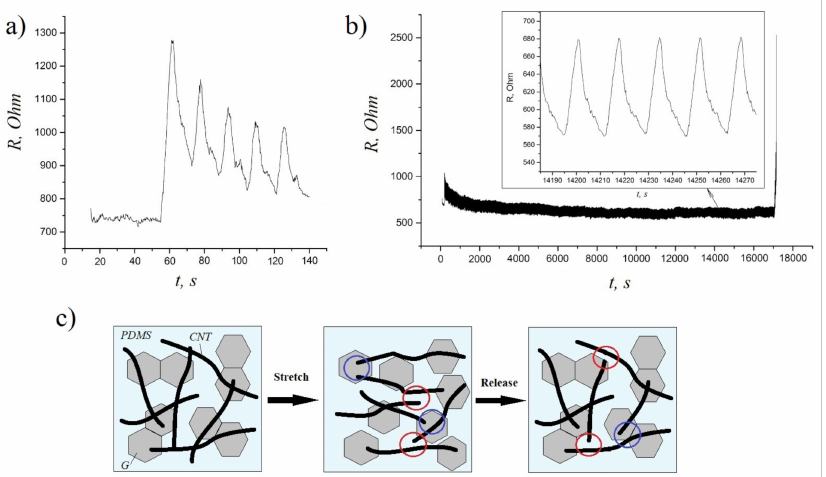
Figure 5. (a ) The resistance response of hybrid composites at the initial cycles of stretching–releasing (0% to 30% strain); ( b ) the resistance response of hybrid composites during >1000 cycles of stretching– releasing (0% to 30% strain); ( c ) the schematic illustration of the mechanism underlying the conduc- tivity of hybrid composites during stretching–releasing cycles.